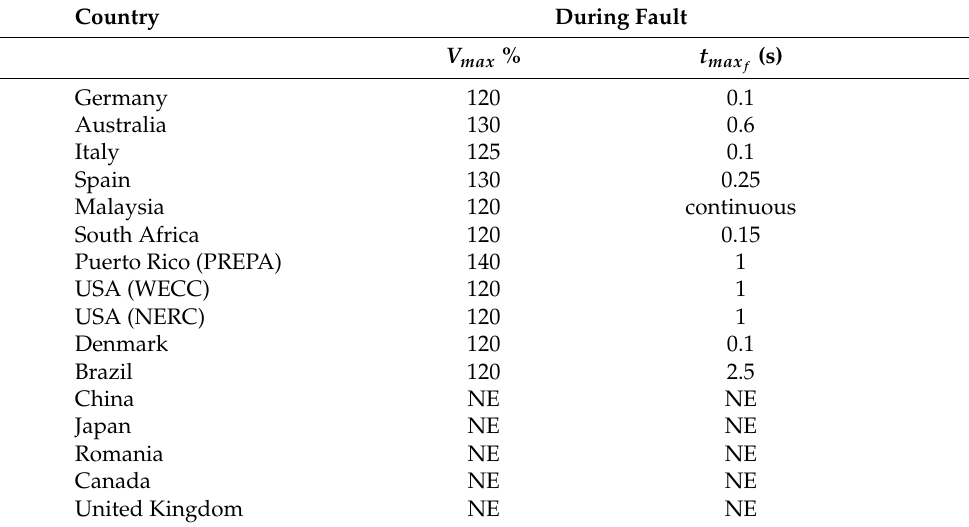
Table 4. Parameters of the HVRT in various